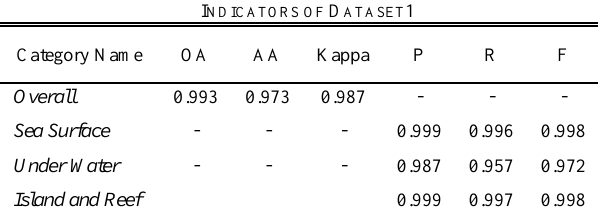
TABLE III I NDICATORS OF D ATASET 1